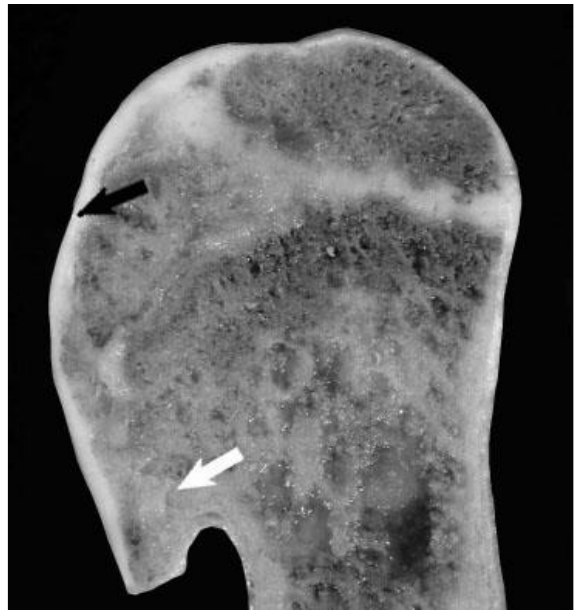
Figure 1. Proximal humerus image of 1-year-old Qianbei-Pockmarked goat with phosphorus deficiency, showing a flattening of the humeral head and separation of articular cartilage from collapsed subchondral bone (black arrow). Also shown is segmental thickening of the physis (white arrow), thickened metaphyseal trabeculae, and thickened cortices. 393 394 We need the file of Figure 1 to 4.